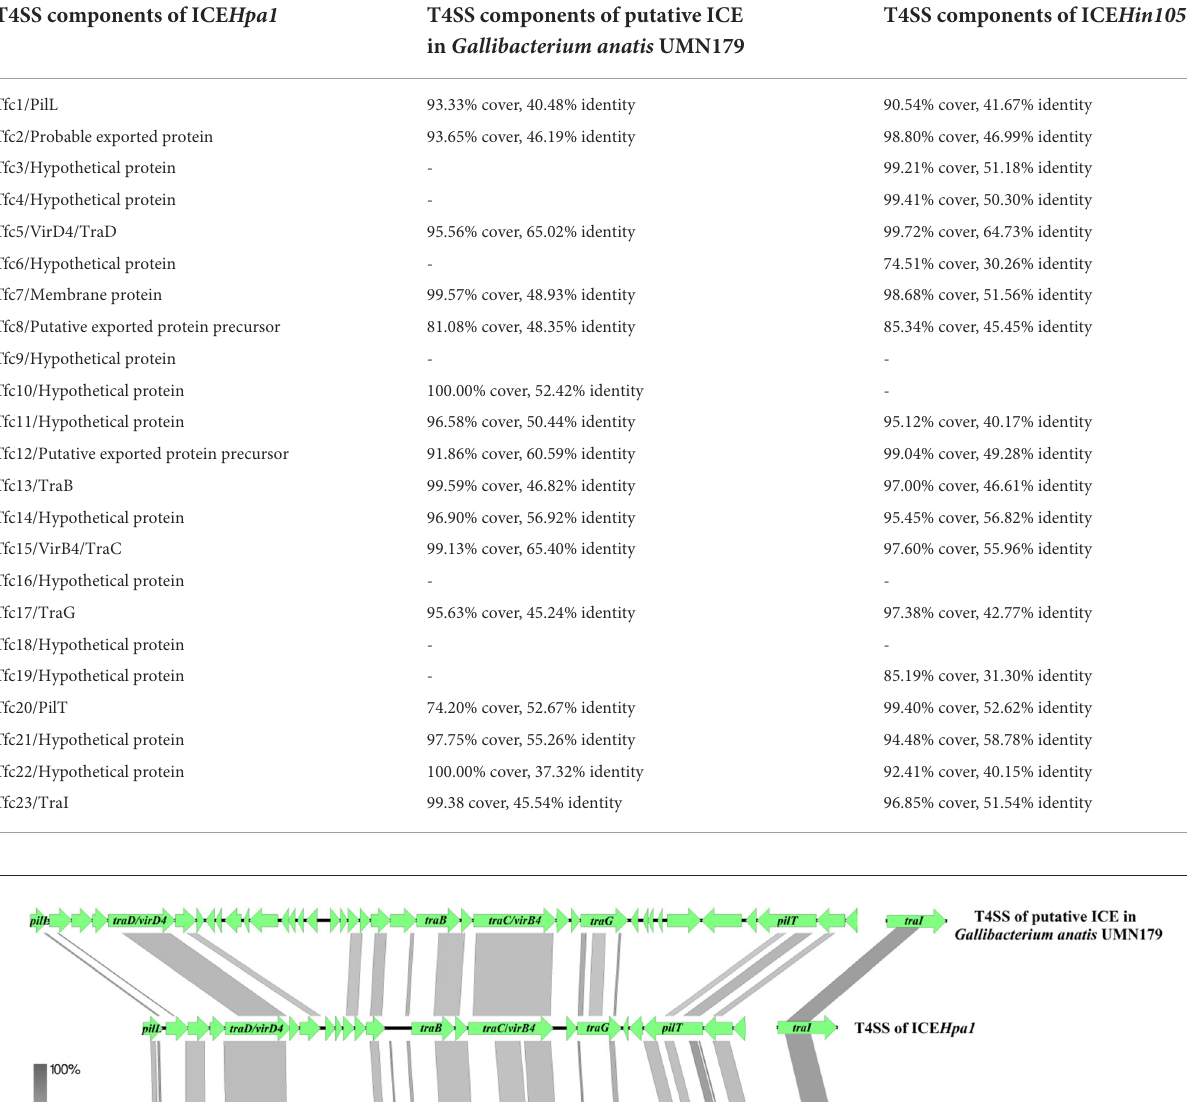
TABLE 4 The deduced amino acid sequence similarities of the putative T4SS components of ICE Hpa1 with the T4SS genes of ICE Hin1056 and putative ICE in Gallibacterium anatis UMN179. T4SS components of ICE Hpa1